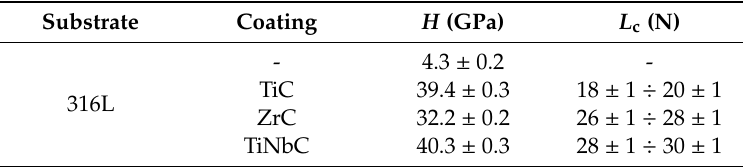
Table 3. Hardness ( H ) and adhesion ( L c ) of uncoated and coated samples.